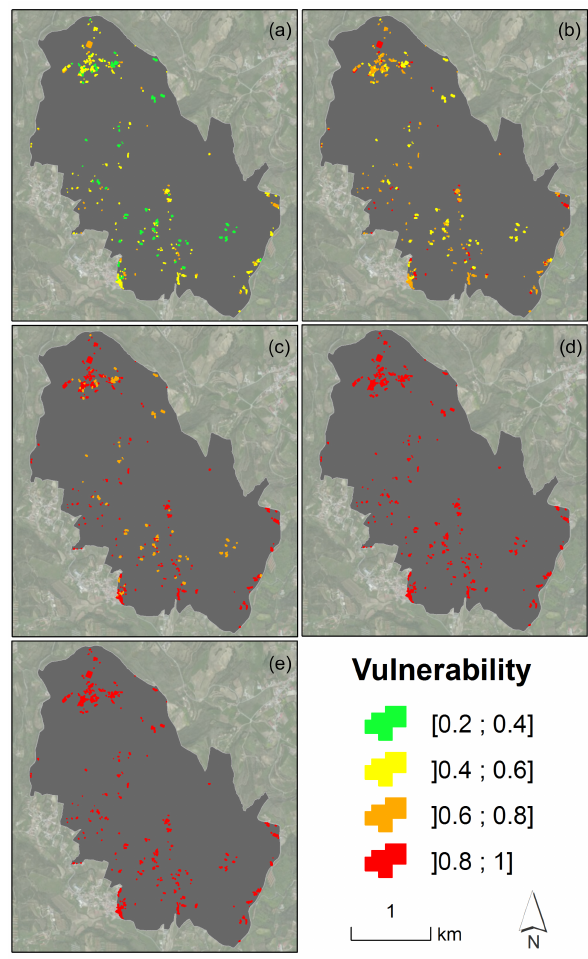
Figure 9. Vulnerability of buildings inventoried in the fieldwork area, located on a landslide body with a slip surface depth of (a) 1m, (b) 3m, (c) 5m, (d) 10m, and (e) 20m.